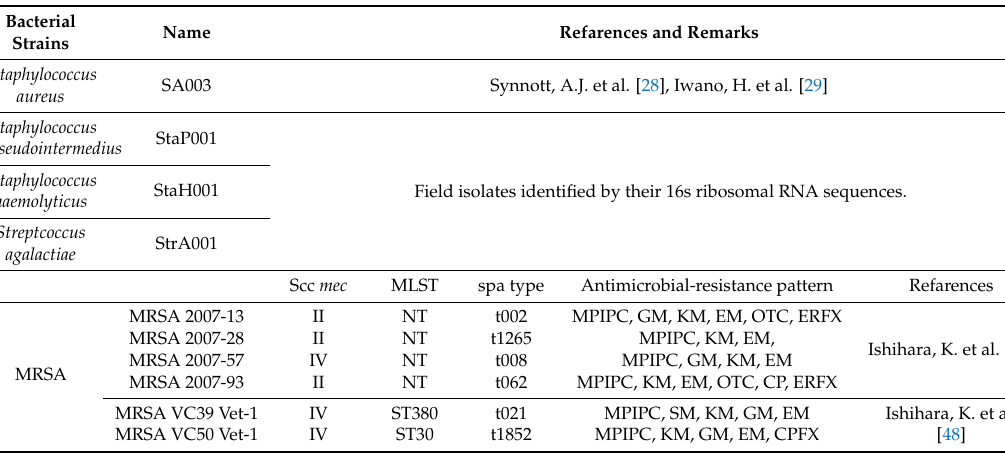
Table 1. Staphylococcal and streptococcal